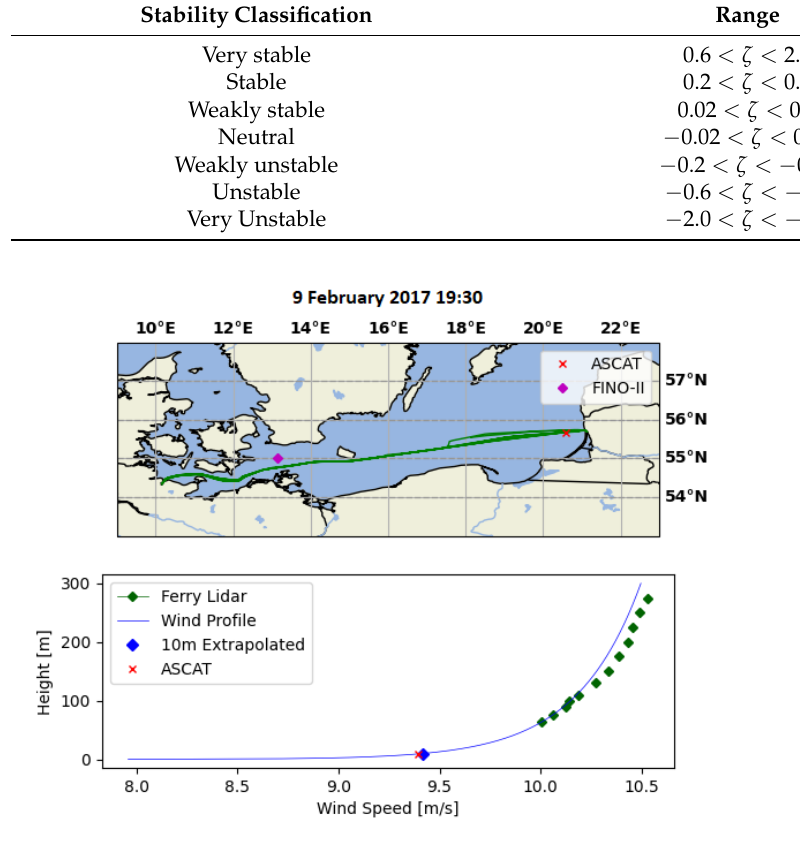
Figure 3. Wind profile extrapolation of co-located ASCAT and lidar measurements on 9 February